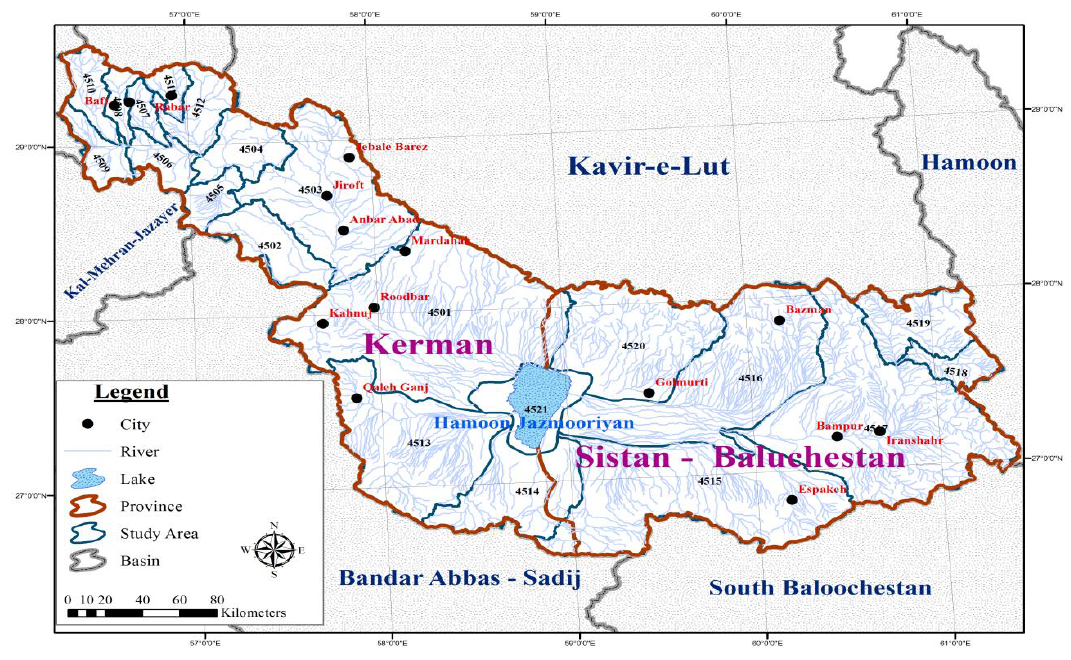
Figure 2. The location of Hamoon- Jazmorian basin